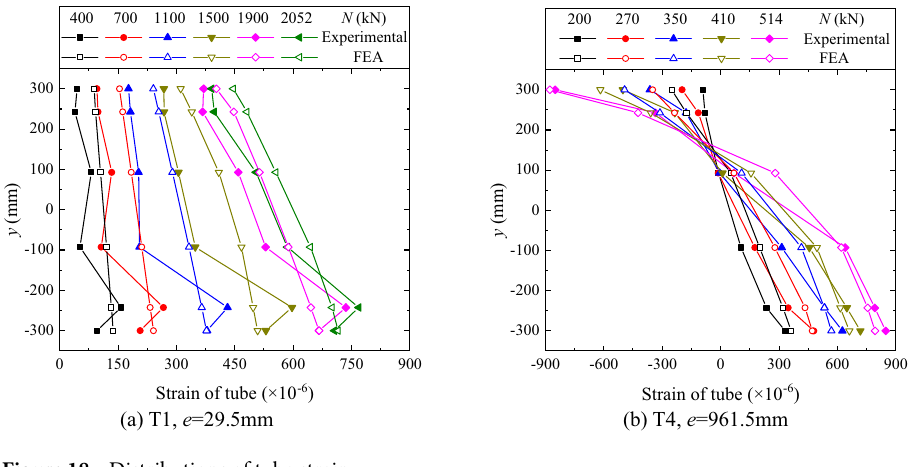
Figure 18. Distributions of tube